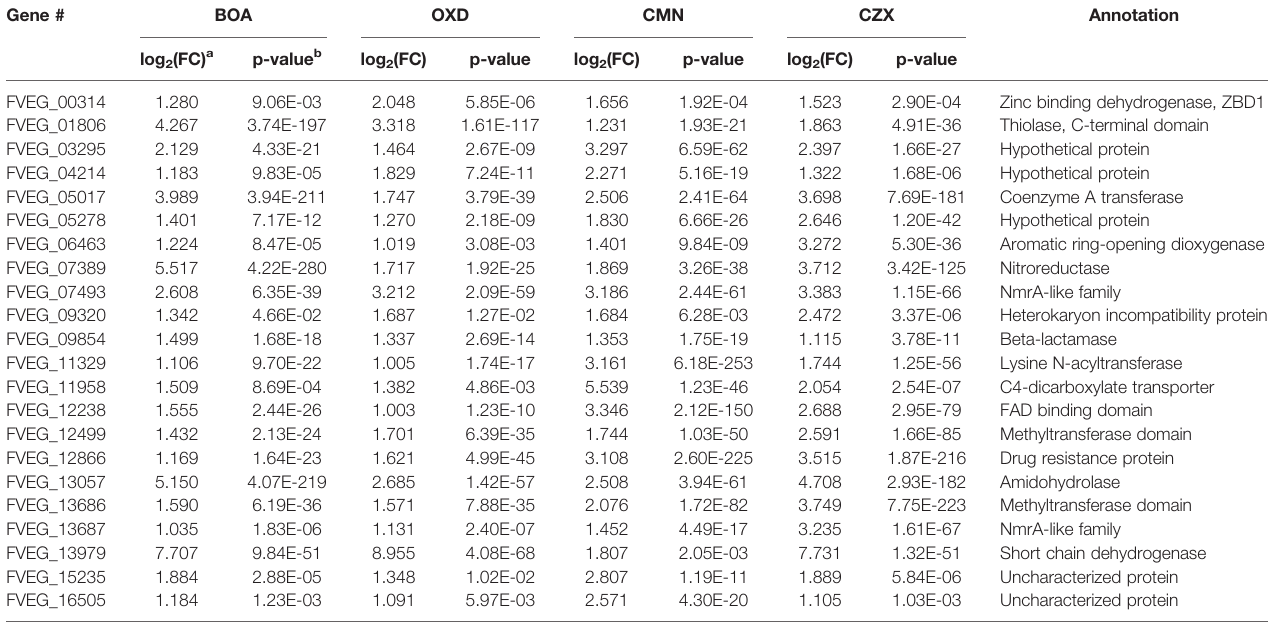
TABLE 5 | Shared induced genes among BOA, OXD, CMN, and CZX